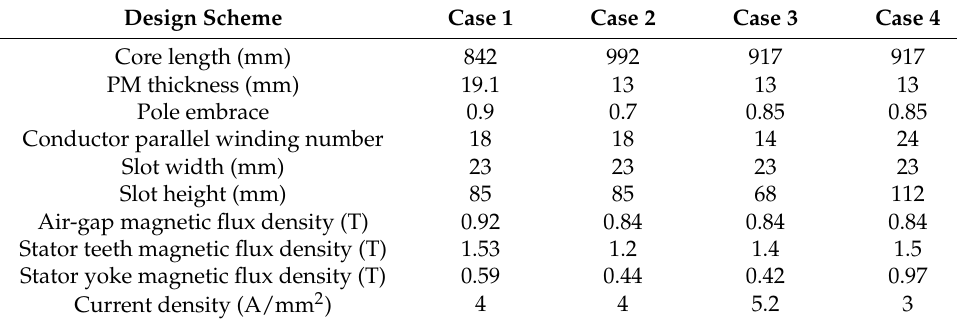
Table 2. The parameters of four schemes.